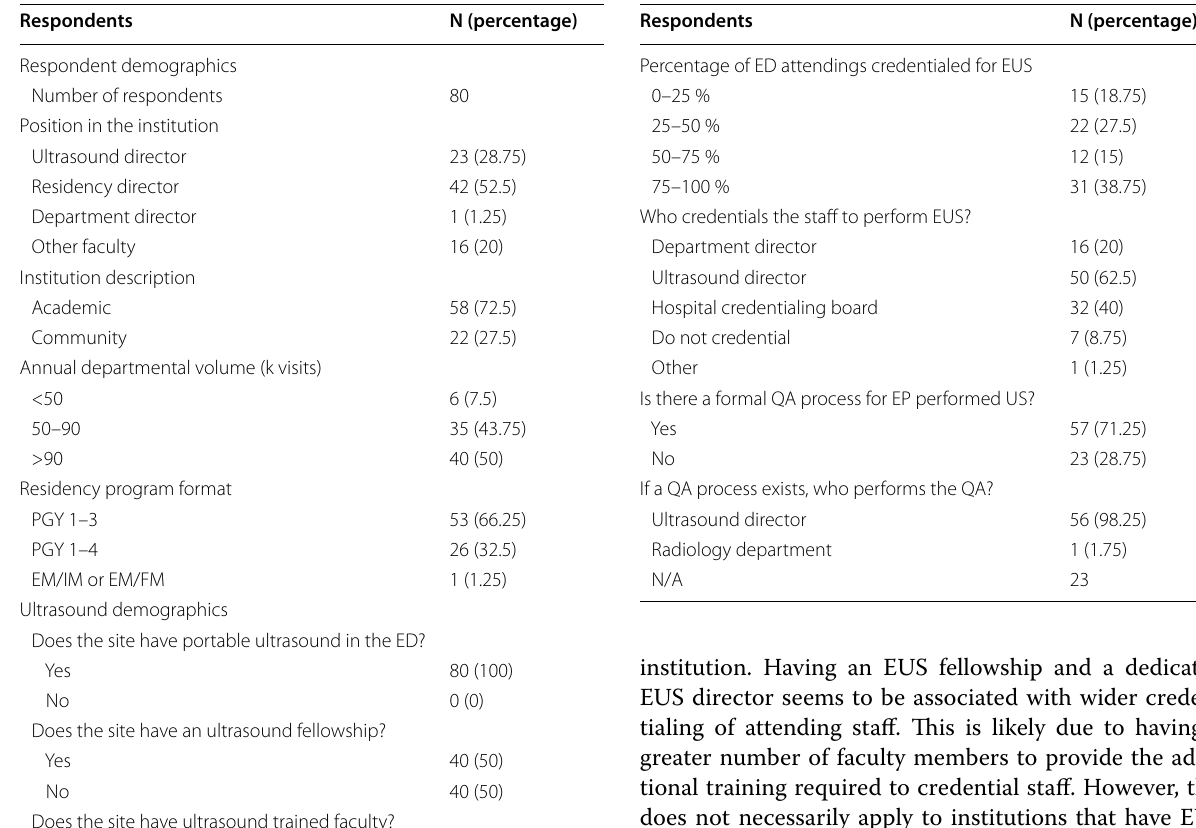
Table 2 Credentialing and quality assurance